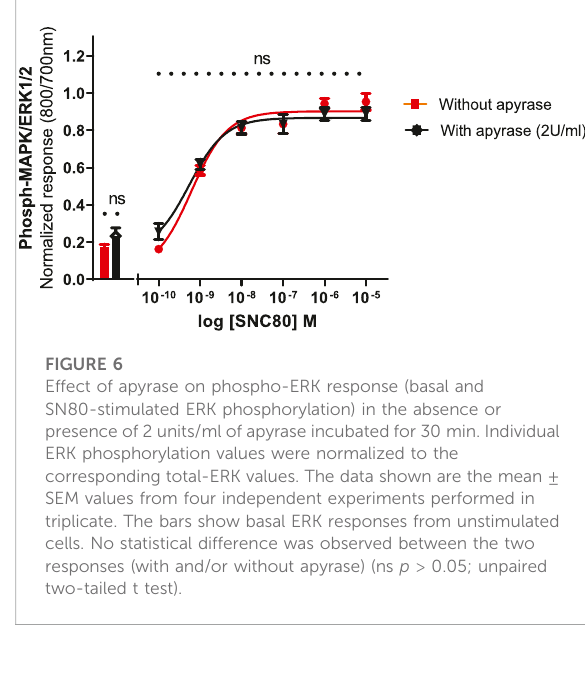
FIGURE 5 Differential effects of SNC80 (1 µM) on ERK activation in serum-replete (10% FBS) versus serum-depleted (no FBS) conditions in CHO-K1-hDOPr cells. The signal is expressed as a normalized ratio (800/700 nm) of phosphorylated to total ERK1/2. The data shown are the mean ± SEM values from three independent experiments performed in triplicate. Statistical signi fi cancewasdeterminedusingone-way ANOVA;*** p < 0.001. Extracellular ATP as a contributor to increased basal ERK signaling.